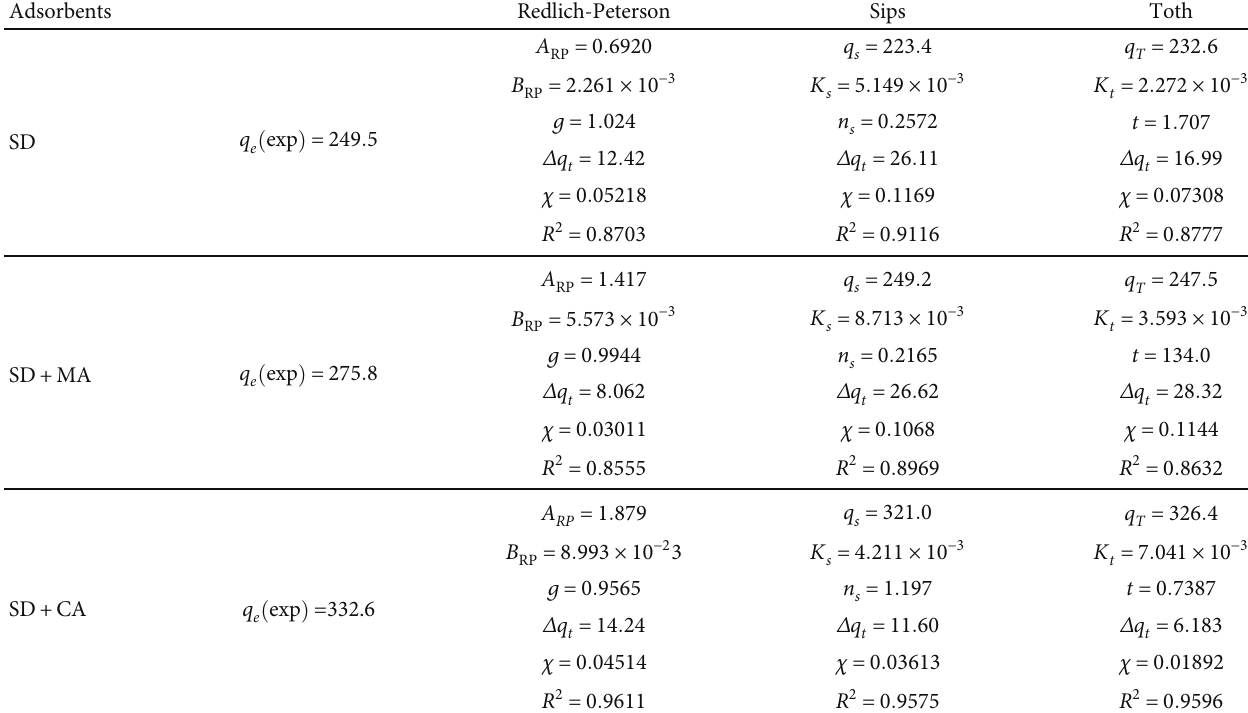
Table 7: Three parameters adsorption isotherm parameters of boron chloride on SD, SD +MA, and SD +CA. Adsorbents